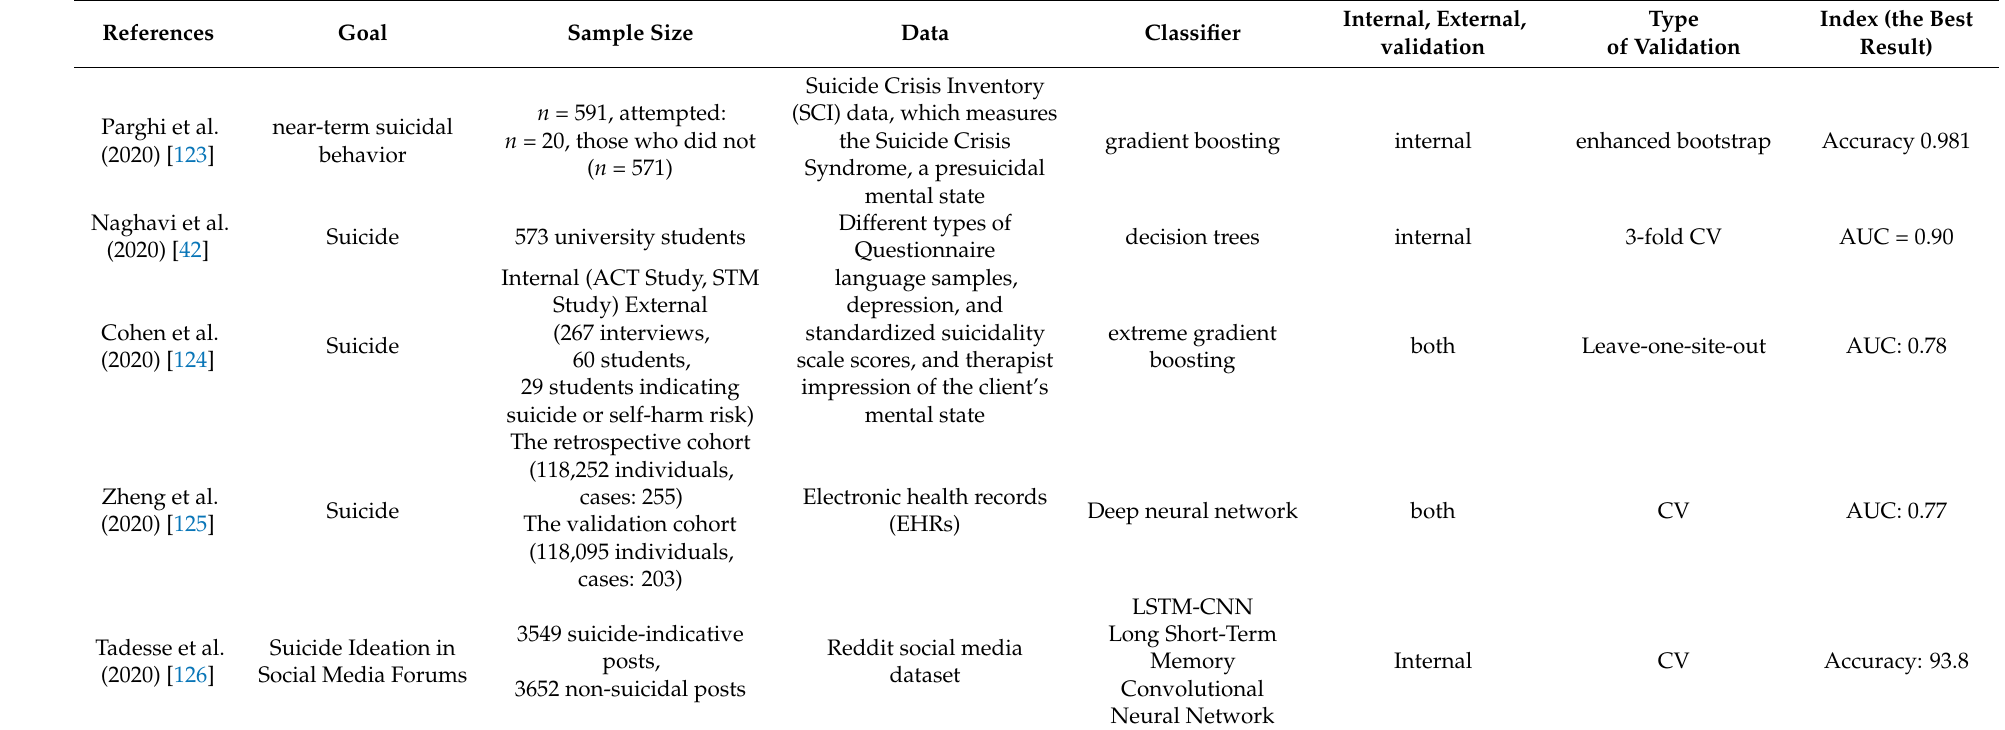
Table 11. CAD methods for suicide prediction